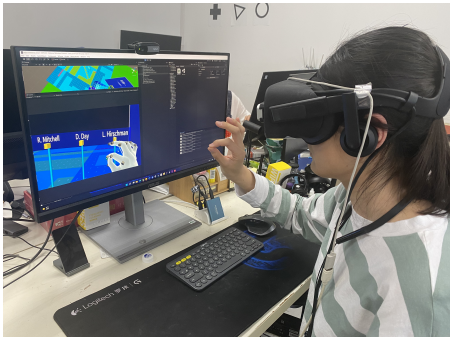
Figure 5. Hardware setup and experimental program interface.